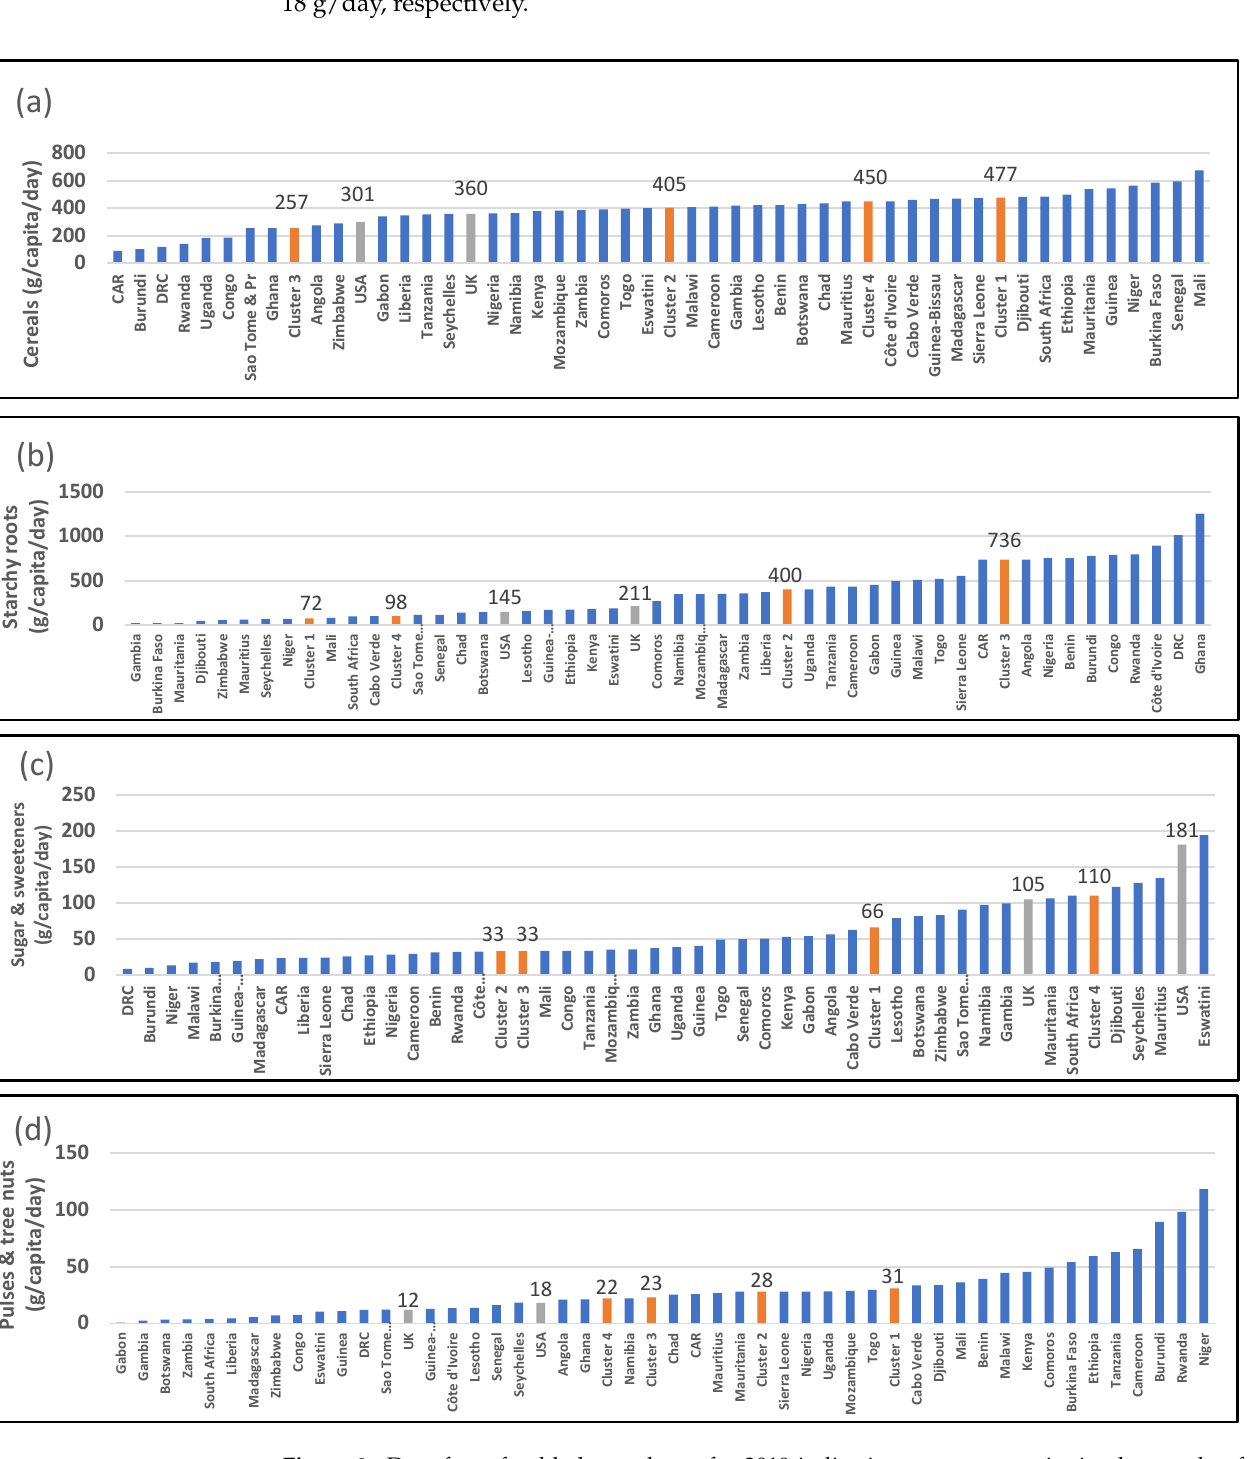
Figure 2. Data from food balance sheets for 2019 indicating gram per capita intake per day for ( a ) cereals, ( b ) starchy roots, ( c ) sugar and sweeteners, and ( d ) pulses and tree nuts. Red columns indicate medians of clusters; source: [25].